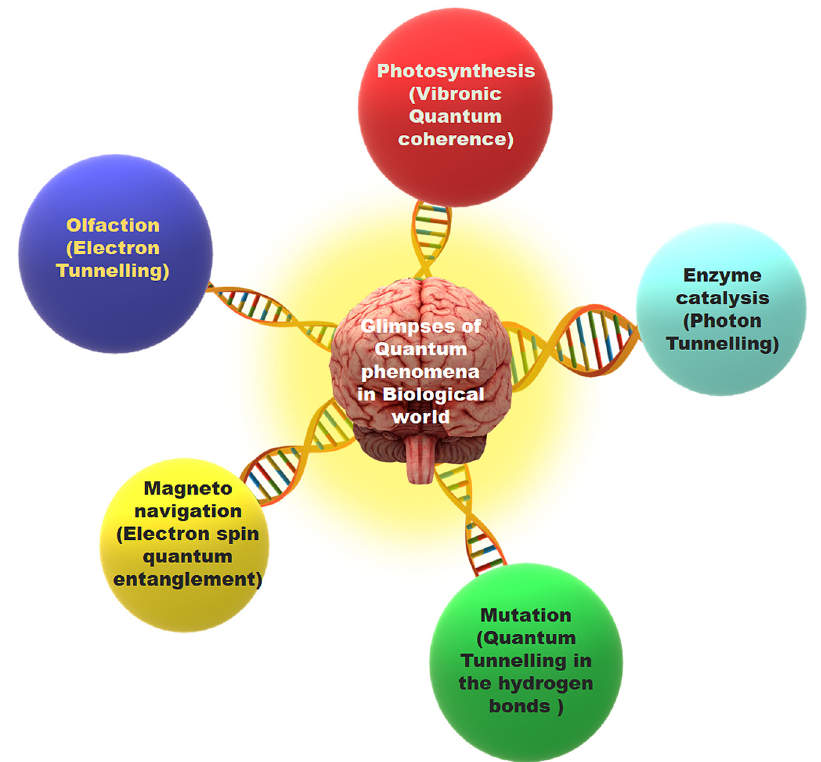
Figure 1: A few prominent biological functions and their correspondingly studied underlying quantum processes/phenomena